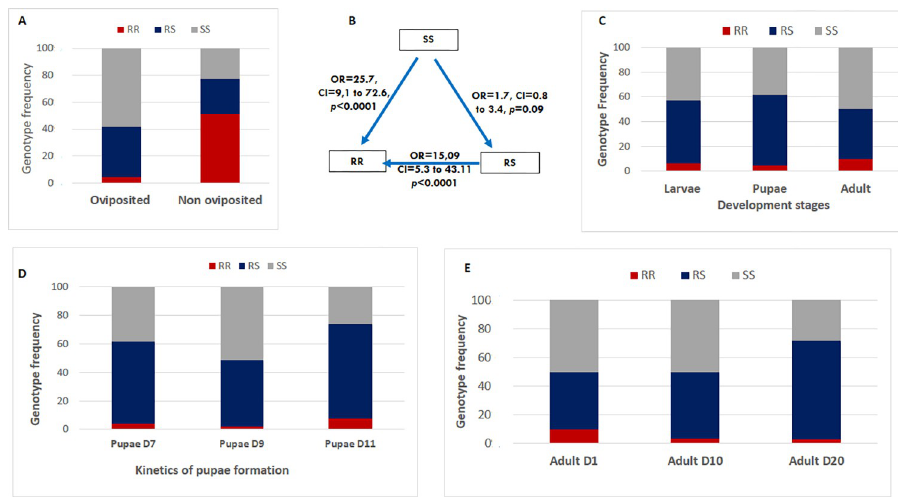
Fig 2. Influence of of the L1014S-KdrE on key life traits of An . gambiae . (A) and (B) Schematic representation of the impact of L1014S genotypes on egg-laying success with odd ratio (OR); (C) Distribution of the L1014S genotypes at different developmental stages of the hybrid MYG/KIS; D) the proportion of pupae obtained in D7, D9 and D11 of development; E) influence of L1014S on the adult longevity of An . gambiae .